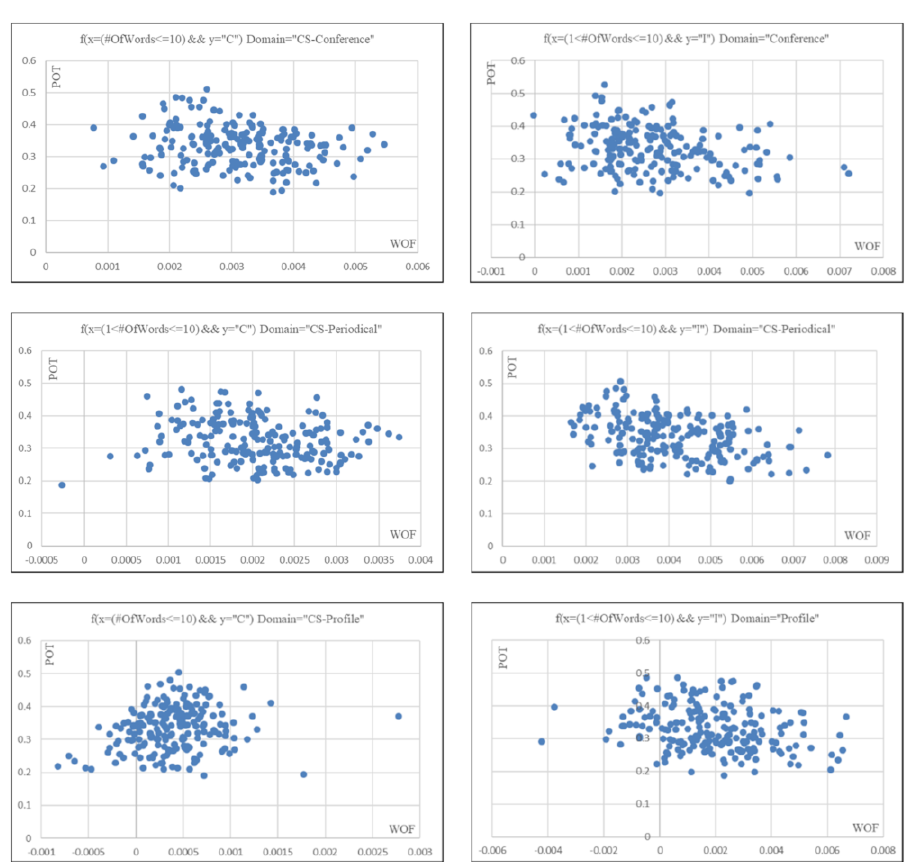
Figure 4. The distribution of label proportions and feature function